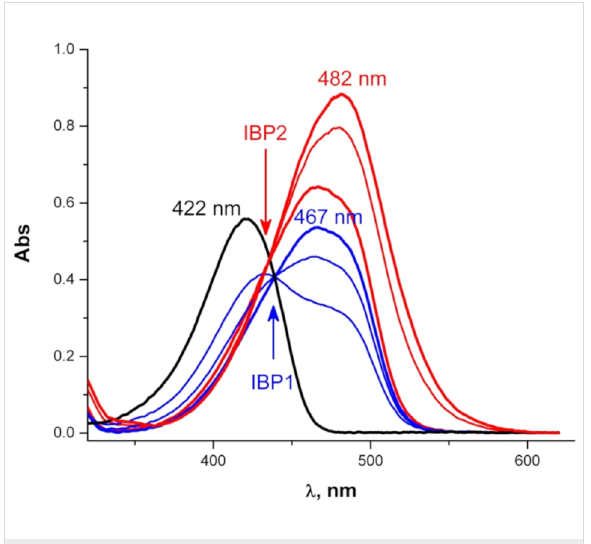
Figure 6: Protonation of 3 in ethanol. Two isosbestic points (IBP) are indicated by arrows.